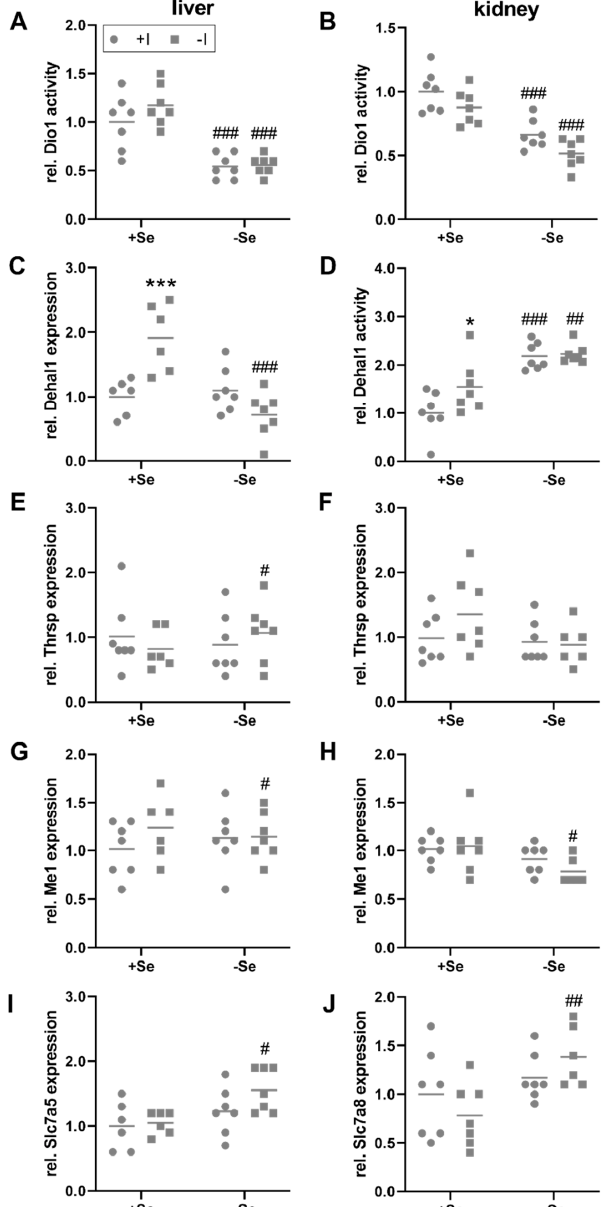
Figure 3. Local TH-induced effects in liver and kidney. To evaluate the impact of TH in liver ( A , C , E , G , I ) and kidney ( B , D , F , H , J ) of C57BL/6Jrj mice (n = 7, outliers excluded), supplied with either low or adequate amounts of selenium (Se) and iodine (I) for 8 weeks, enzyme activities ( A , B , D ) and gene expression ( C , E – J ) were assessed. Dio1 ( A – B ) and Dehal1 activity ( D ) were determined by Sandell-Kolthoff-based activity assays in liver ( A ) and kidney ( B , D ). Further, Dehal1 ( C ), Thrsp ( E , F ), Me1 ( G – H ), Slc7a5 ( I ), and Slc7a8 ( J ) expression was analyzed in liver ( C , E , G , I ) and kidney ( F , H , J